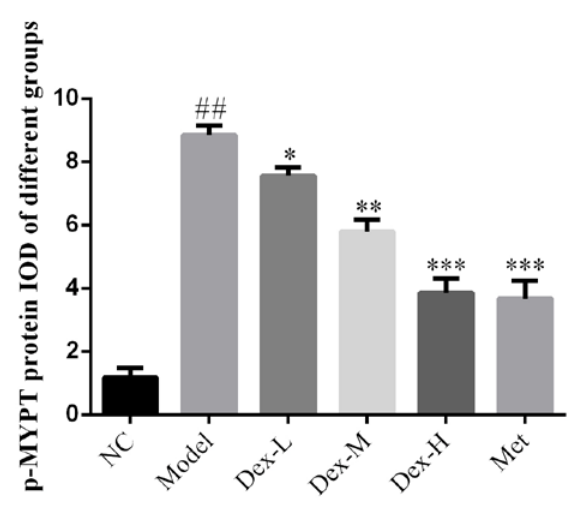
Figure 7: Comparison of p-MYPT protein expression in Kidney of Rats in Each